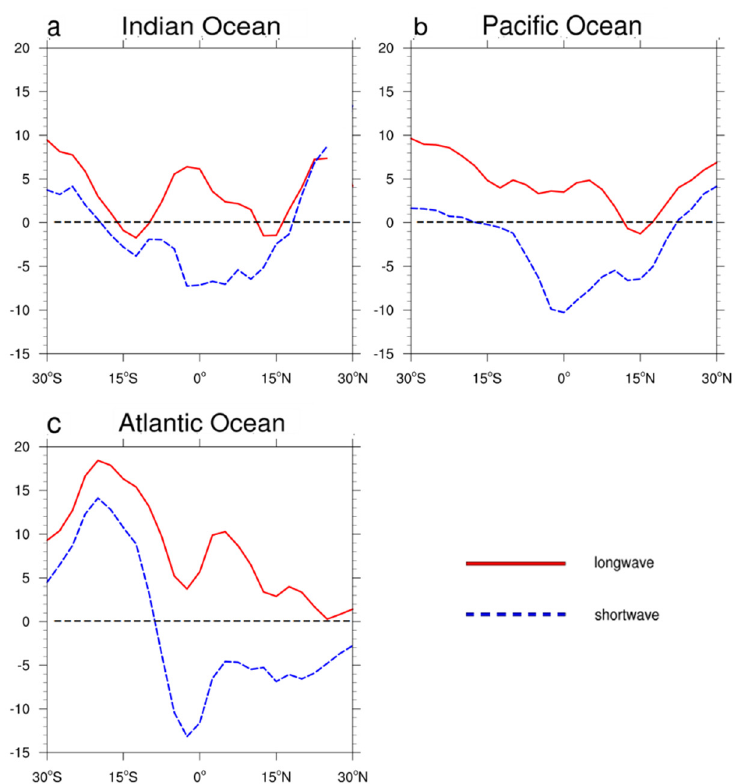
Figure 5. Latitudinal distribution of bias (model ensemble minus OAFLux) in Q LW (red solid line) and Q SW (blue dotted line) in the ( a ) Indian (40 ° E–100 ° E), ( b ) Pacific (100 ° E–80 ° W), and ( c ) Atlantic (80 ° W–10 ° E) oceans. (unit: w m − 2 ).